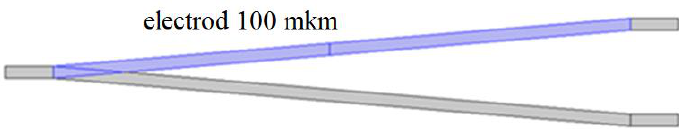
Fig. 3. Model of a Y-divider with a control